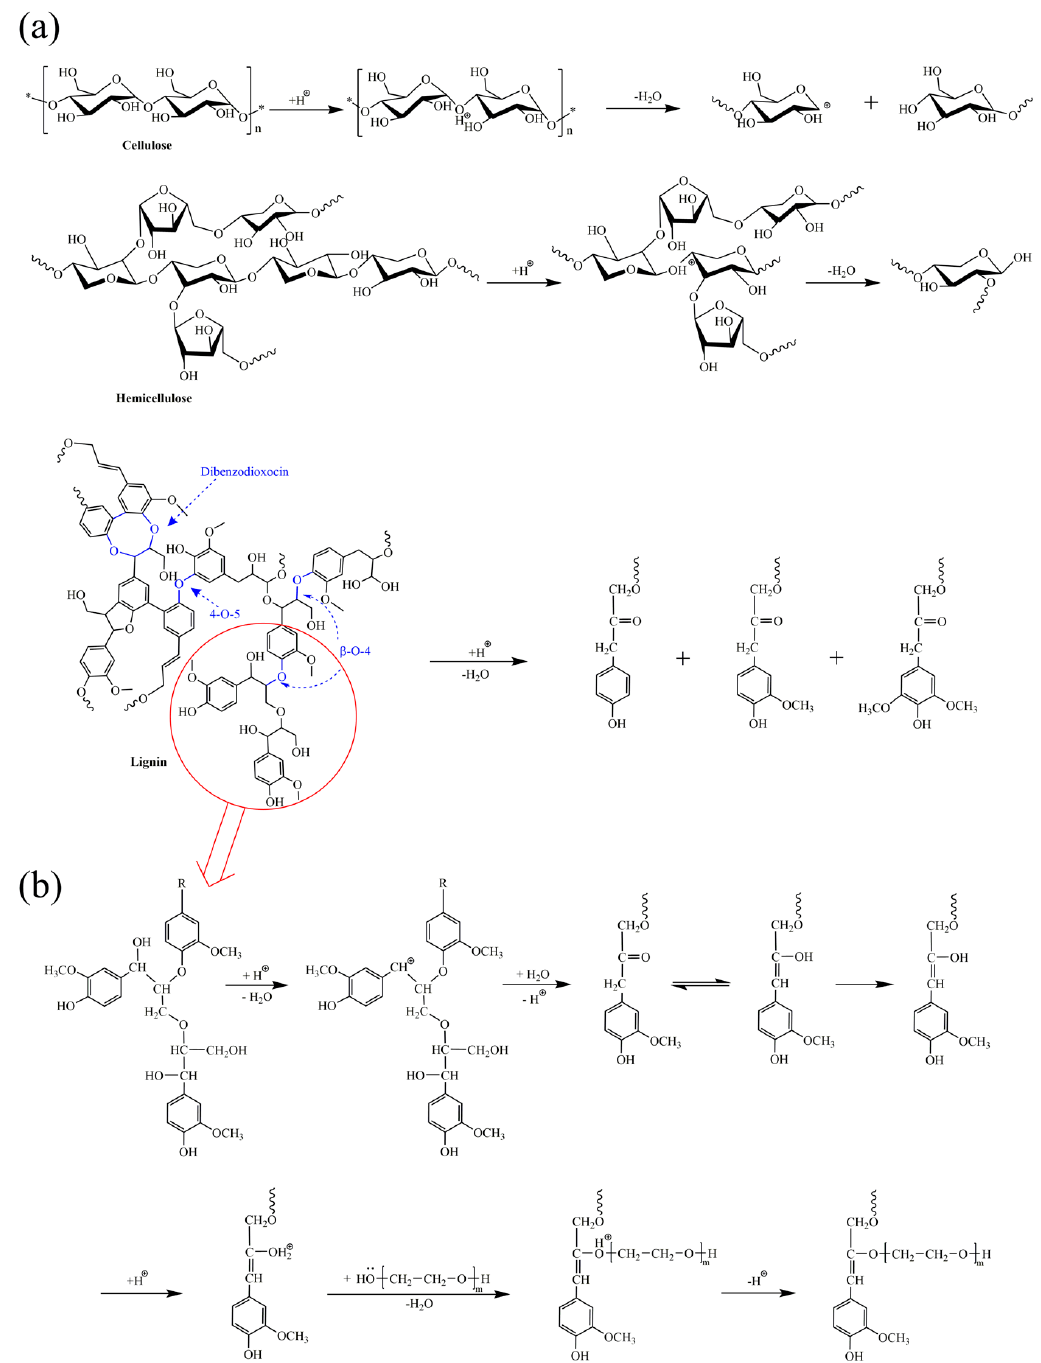
Figure 6. Proposed depolymerization of cellulose, hemicellulose and lignin in CS ( a ), and repolymerization pathways for lignin derivatives and PEG400 ( b ) in the solvolysis liquefaction process.